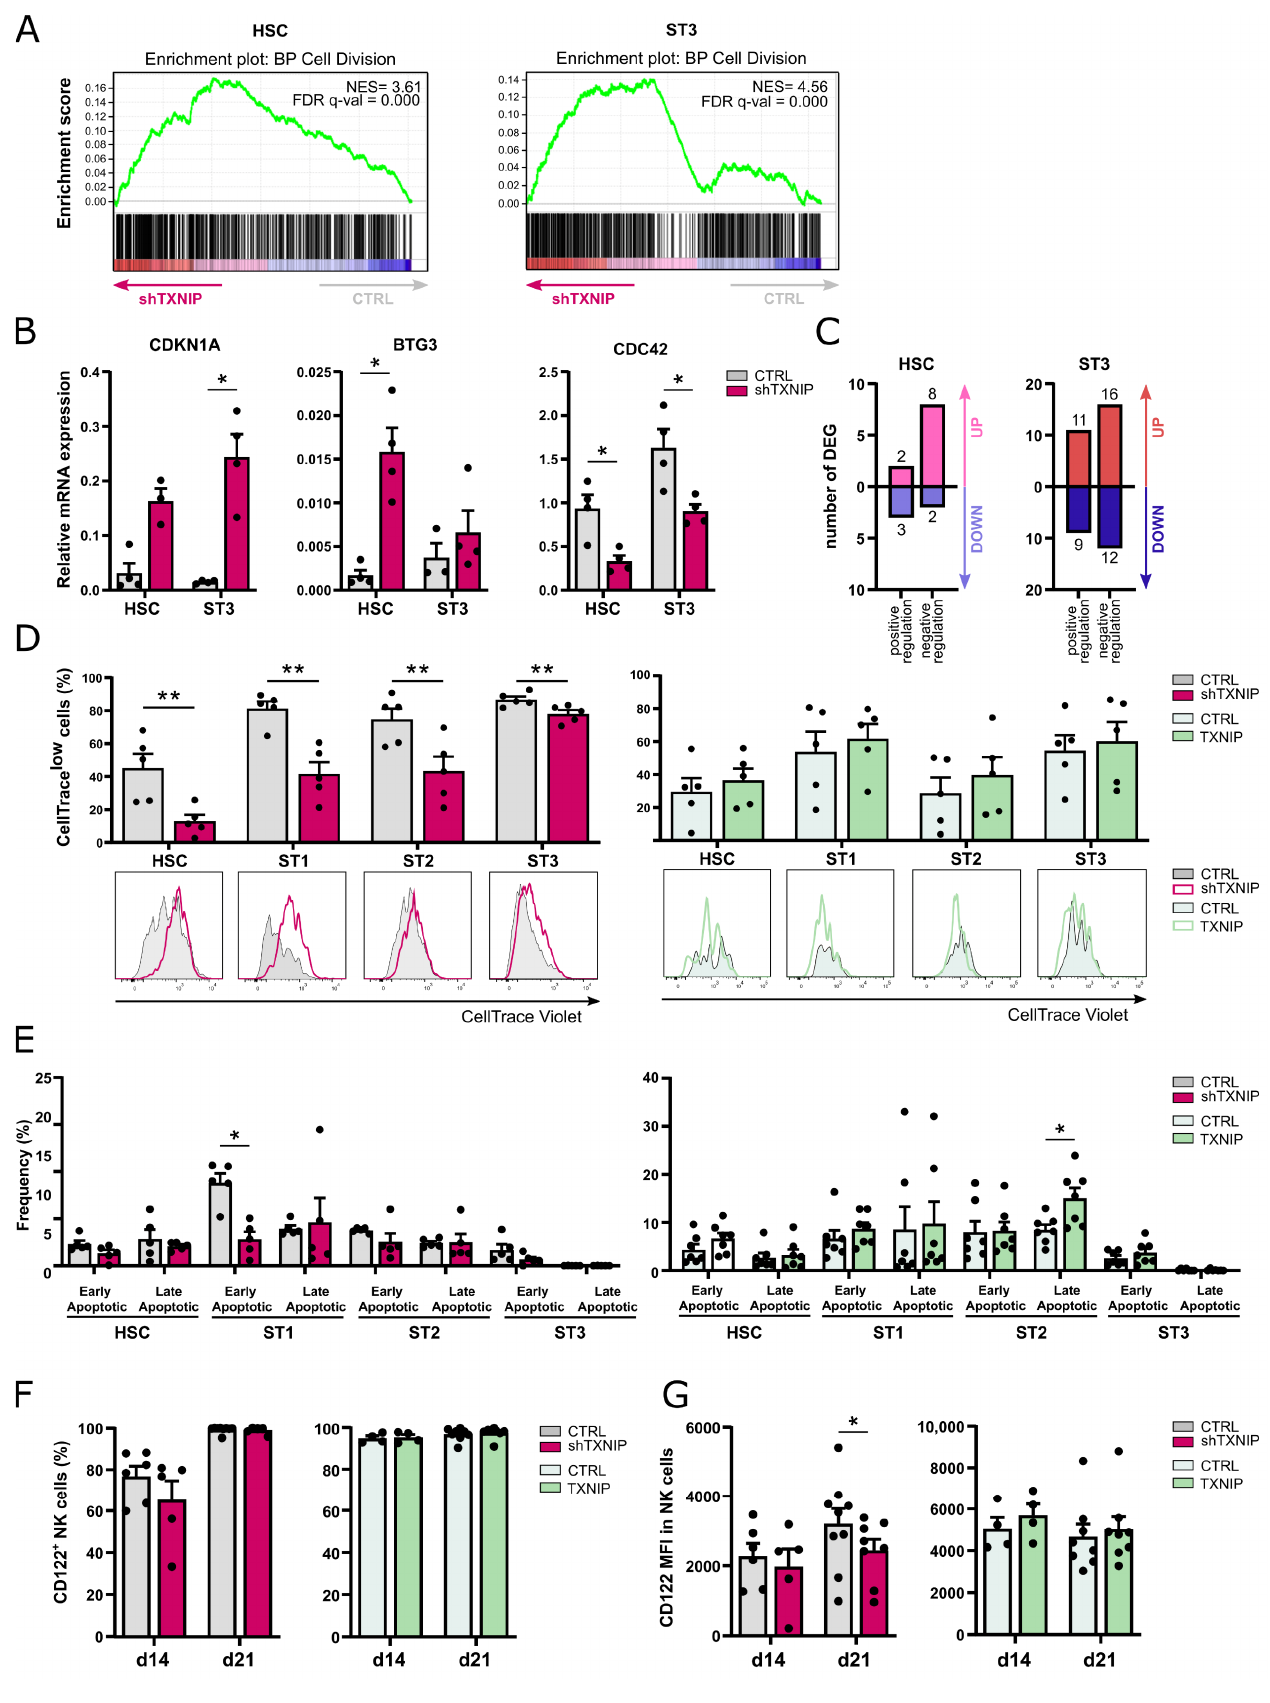
Figure 3. Decreased proliferation of early NK cell developmental stages upon TXNIP